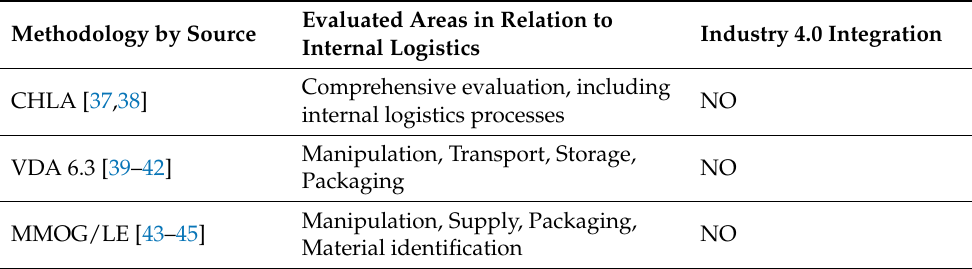
Table 2. Evaluation methodologies of logistics